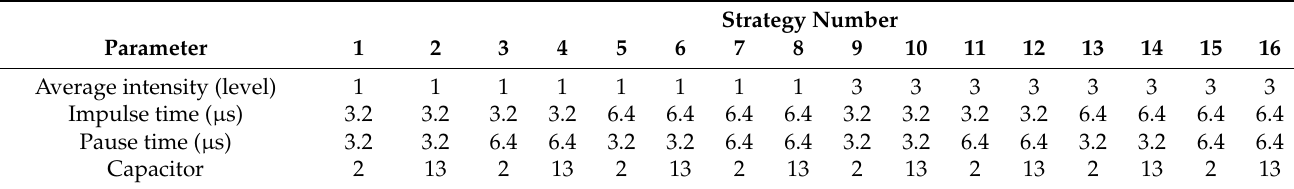
Table 4. Strategies defined for EDM